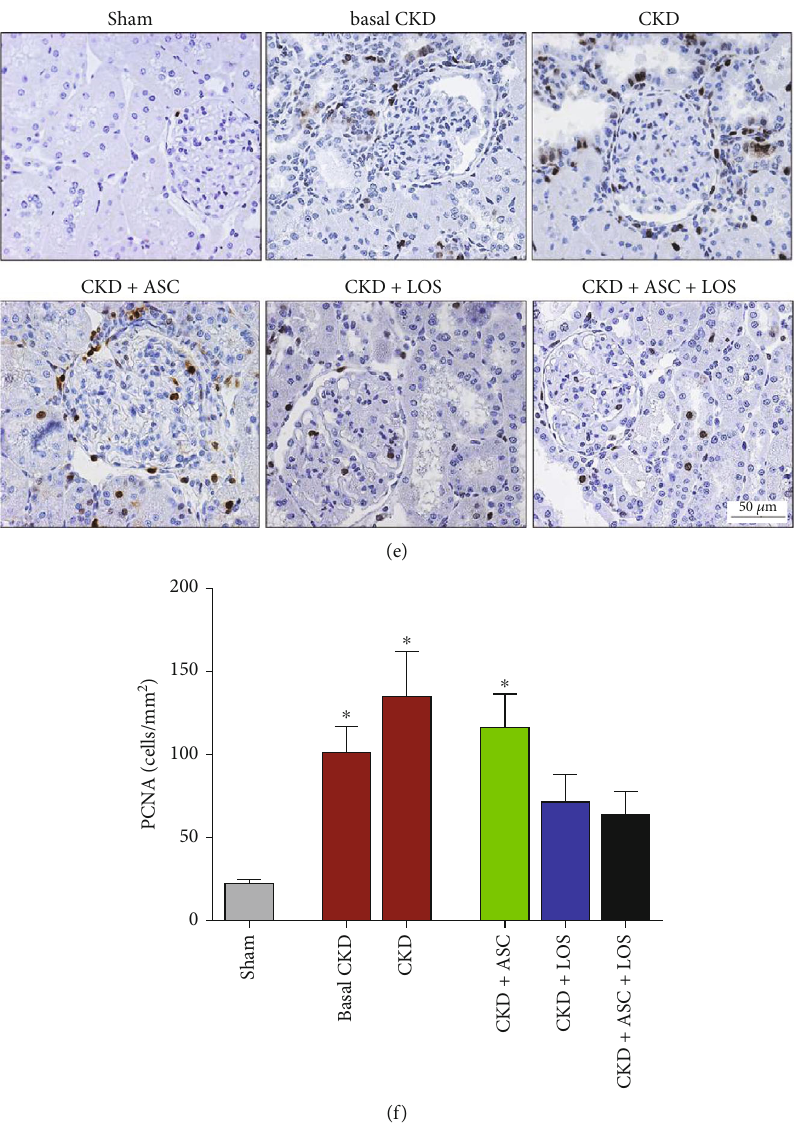
Figure 5: Local renal in fl ammation. Illustrative microphotographs of immunohistochemistry for (a) macrophages (CD68), (C) T-cells (CD3), and (e) proliferating interstitial cells (PCNA), in each experimental group. Bar graphs representing the number of (b) macrophages, (d) T-lymphocytes, and (f) PCNA (cells/mm 2 ) in the renal cortical interstitial area. Statistical di ff erences are ∗ p < 0 : 05 vs. Sham, § p < 0 : 05 vs. basal CKD, # p < 0 : 05 vs. CKD, † p < 0 : 05 vs. CKD+ ASC, and ‡ p < 0 : 05 vs. CKD+